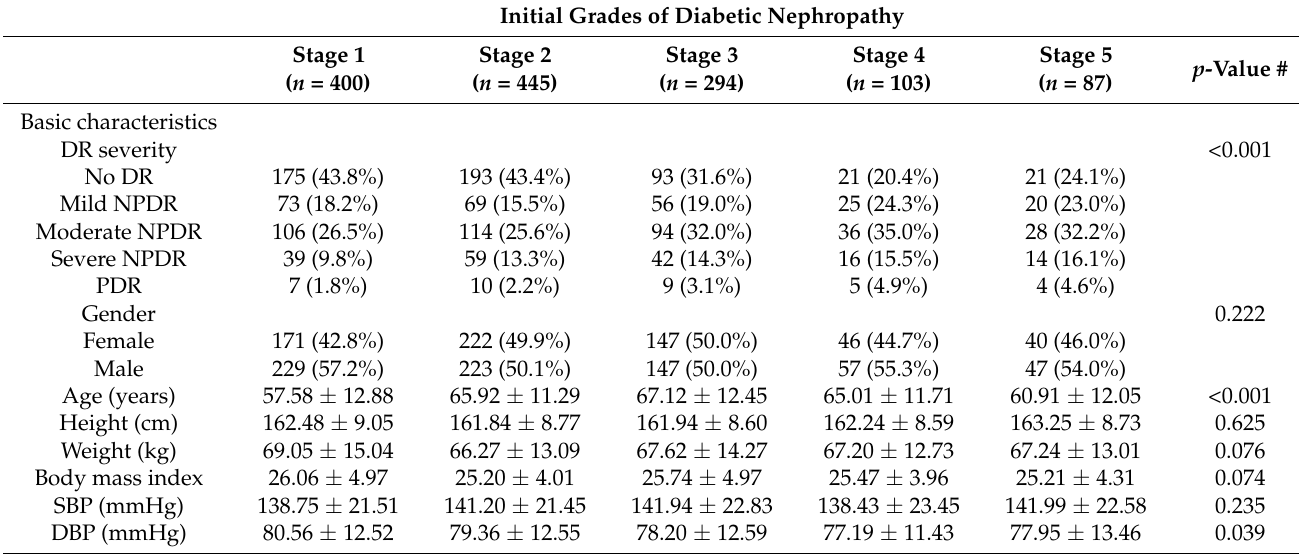
Table 1. The characteristics of patients with different initial grades of diabetic